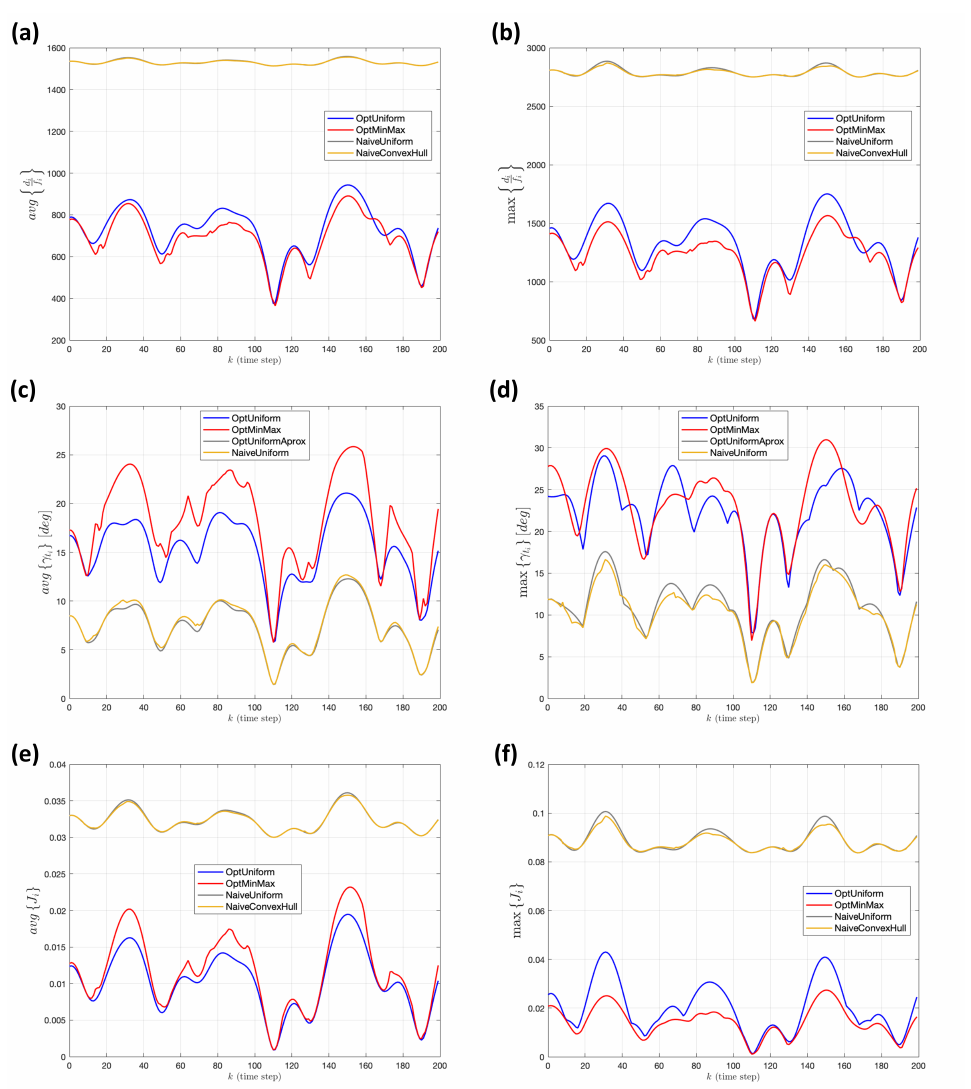
Figure 13. Experiment 1. ( a , b ) Instantaneous mean and maximum values in optical range , respectively. ( c , d ) Corresponding mean a maximum measures for the deficit in verticality . ( e , f ) Mean and maximum values of the set of individual optimization terms J i